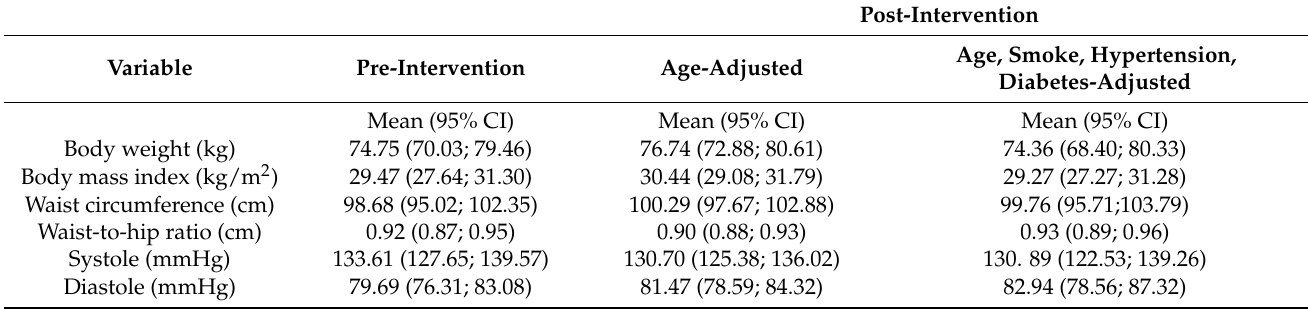
Table 3. Repeated ANCOVA for pre-intervention against post-intervention